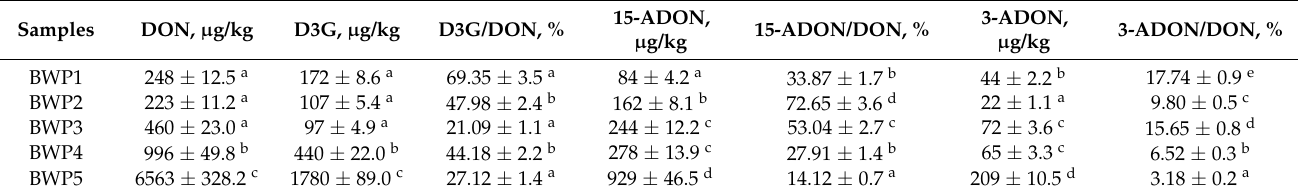
Table 1. Concentrations ( µ g/kg) of deoxynivalenol and its conjugates in barley wholemeal initial